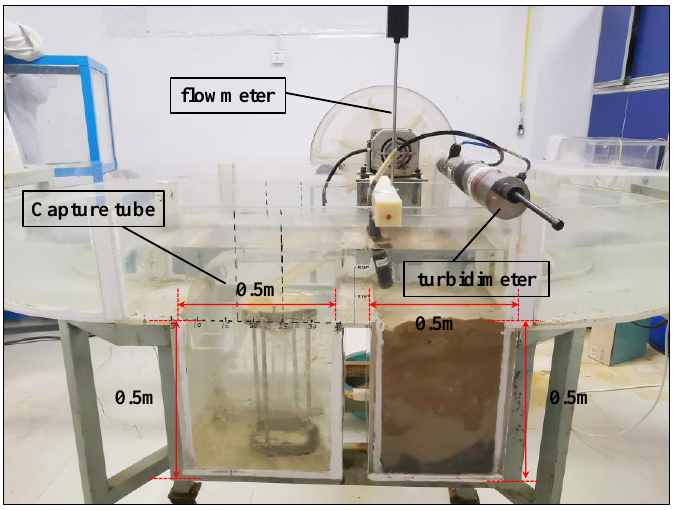
Figure 9. Flux analysis test.